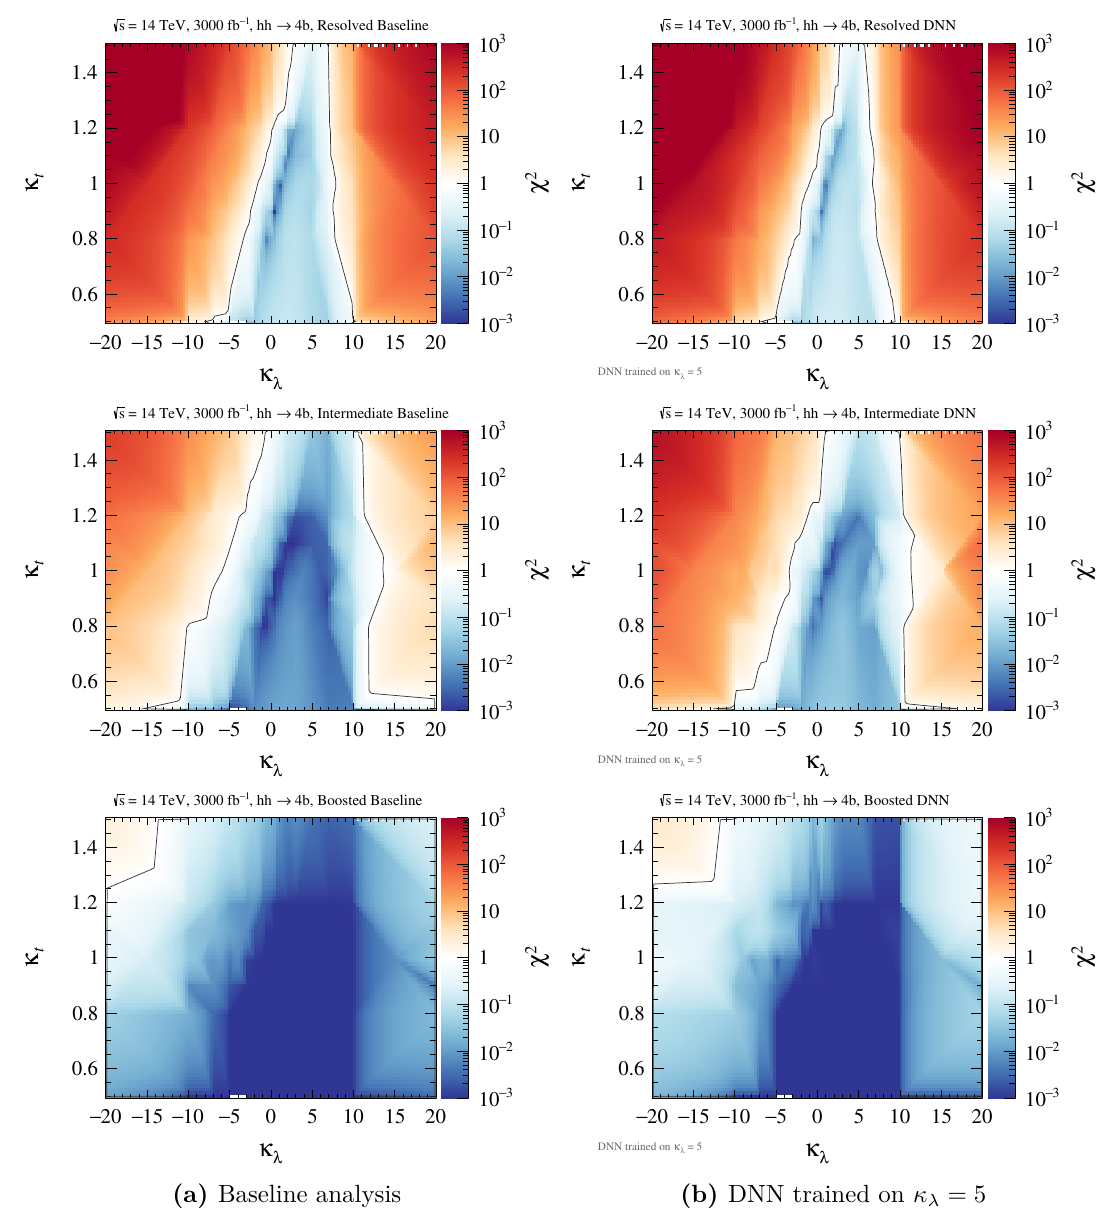
Figure 28. The χ 2 distributions for the (a) baseline analysis and (b) neural network analysis trained on the κ λ = 5 signal. This is displayed in the κ t vs κ λ plane at L = 3000 fb − 1 . This is shown for the resolved (upper), intermediate (middle), boosted (lower) categories assuming 0.3%, 1% and 5% systematic uncertainties, respectively. The grey contour indicates χ 2 = 1 corresponding to 68%